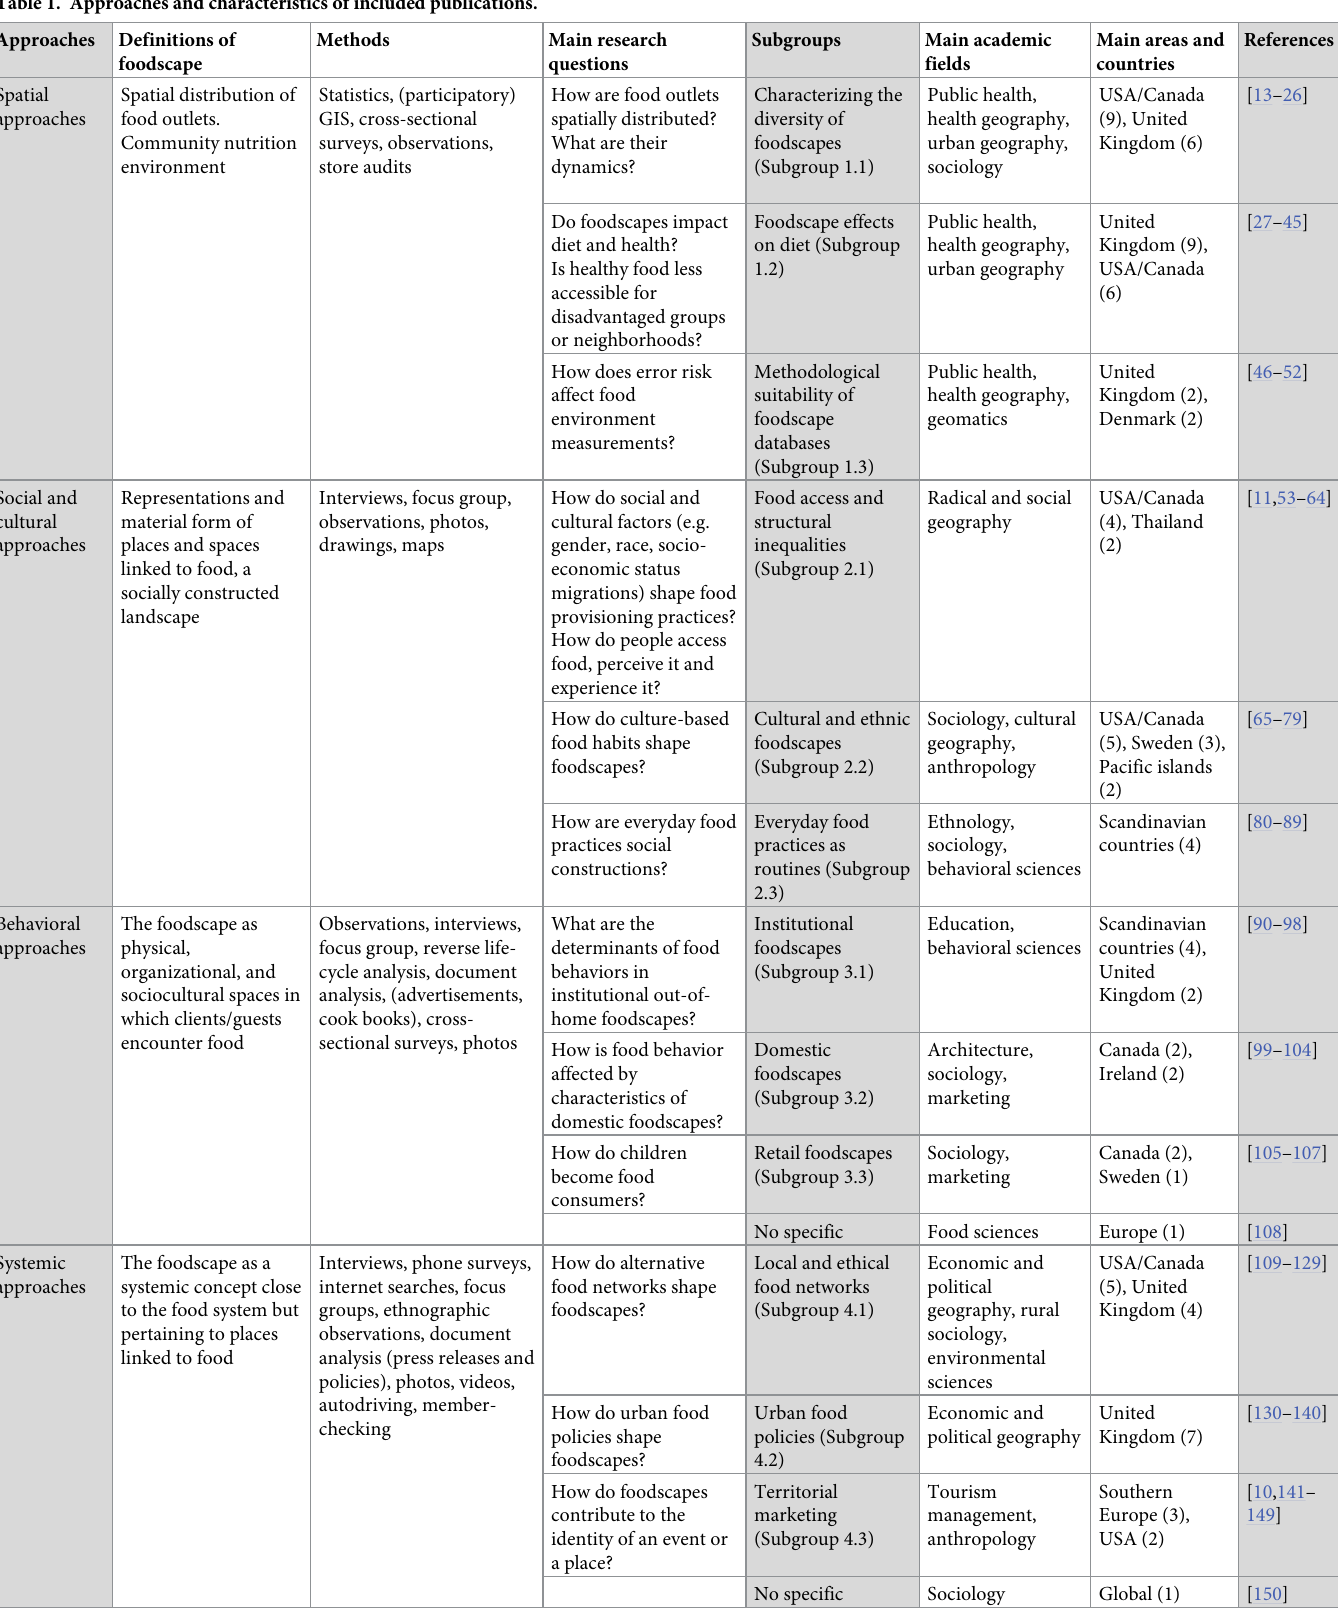
Table 1. Approaches and characteristics of included